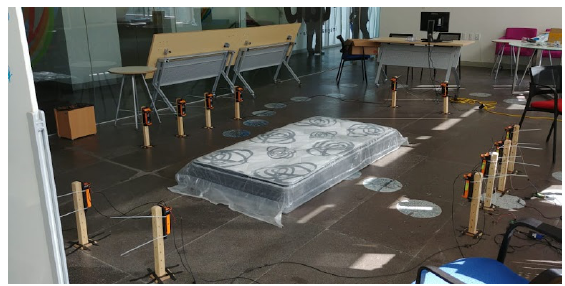
Figure 2. Implementation of the laboratory room for data